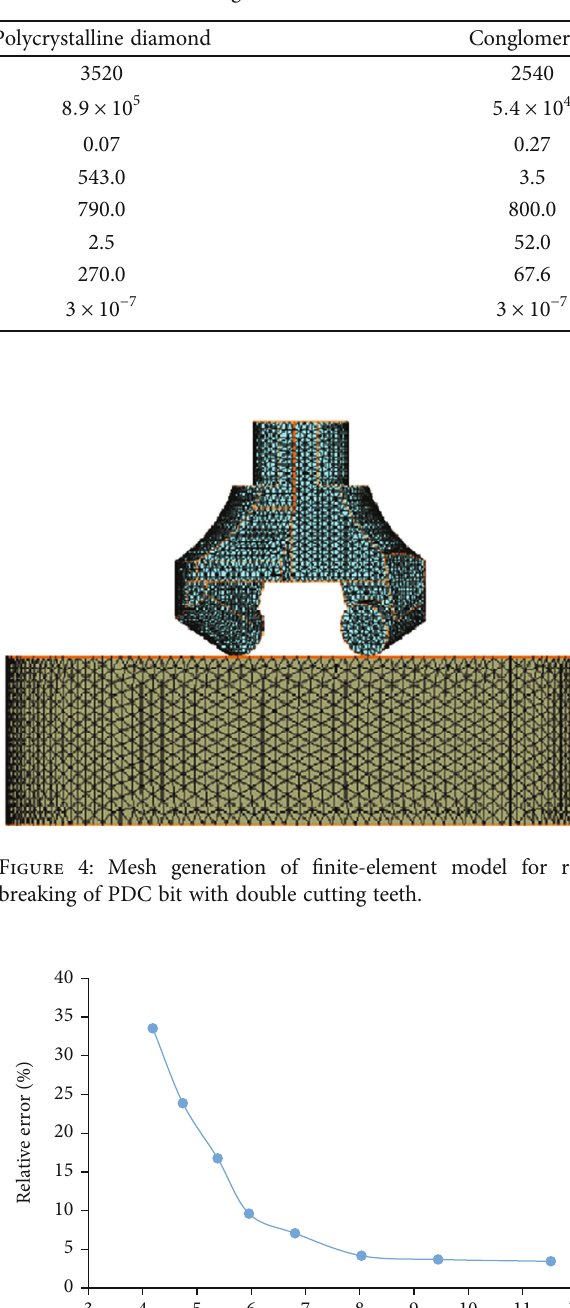
Table 1: Attribute parameters of polycrystalline diamond and